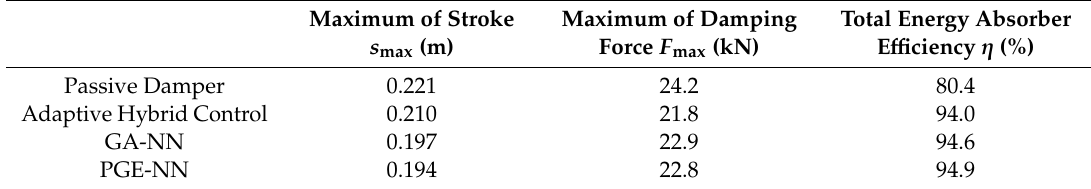
Table 4. E ffi ciency of the landing gear using the passive damper, adaptive hybrid control, GA-NN, and PGE-NN in the case of m 1 = 680 kg and v = 3 m / s.